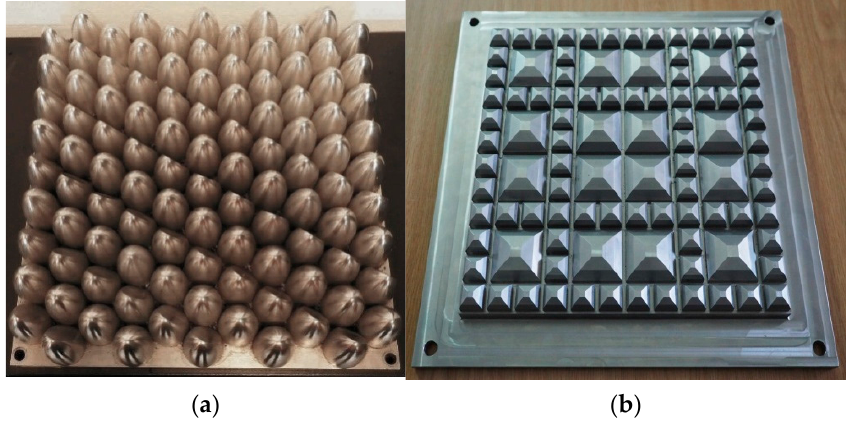
Figure 1. Ballast plates used in UBM tests: ( a ) formed steel plate used in fatigue tests according to UNI 11059 [27]; ( b ) geometric ballast plate (GBP) according to EN 17282 [24].